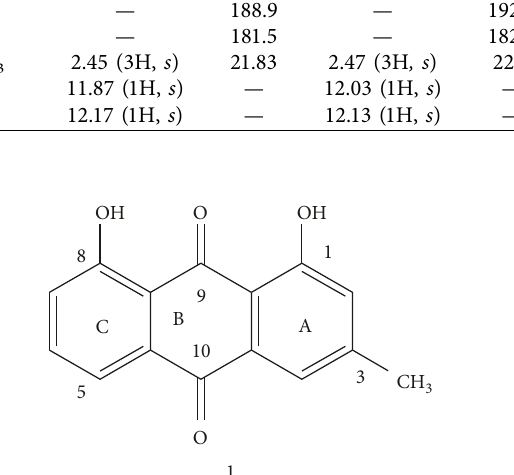
Figure 1: Picture of the study plant (photo taken by Asnakew, September 2017).